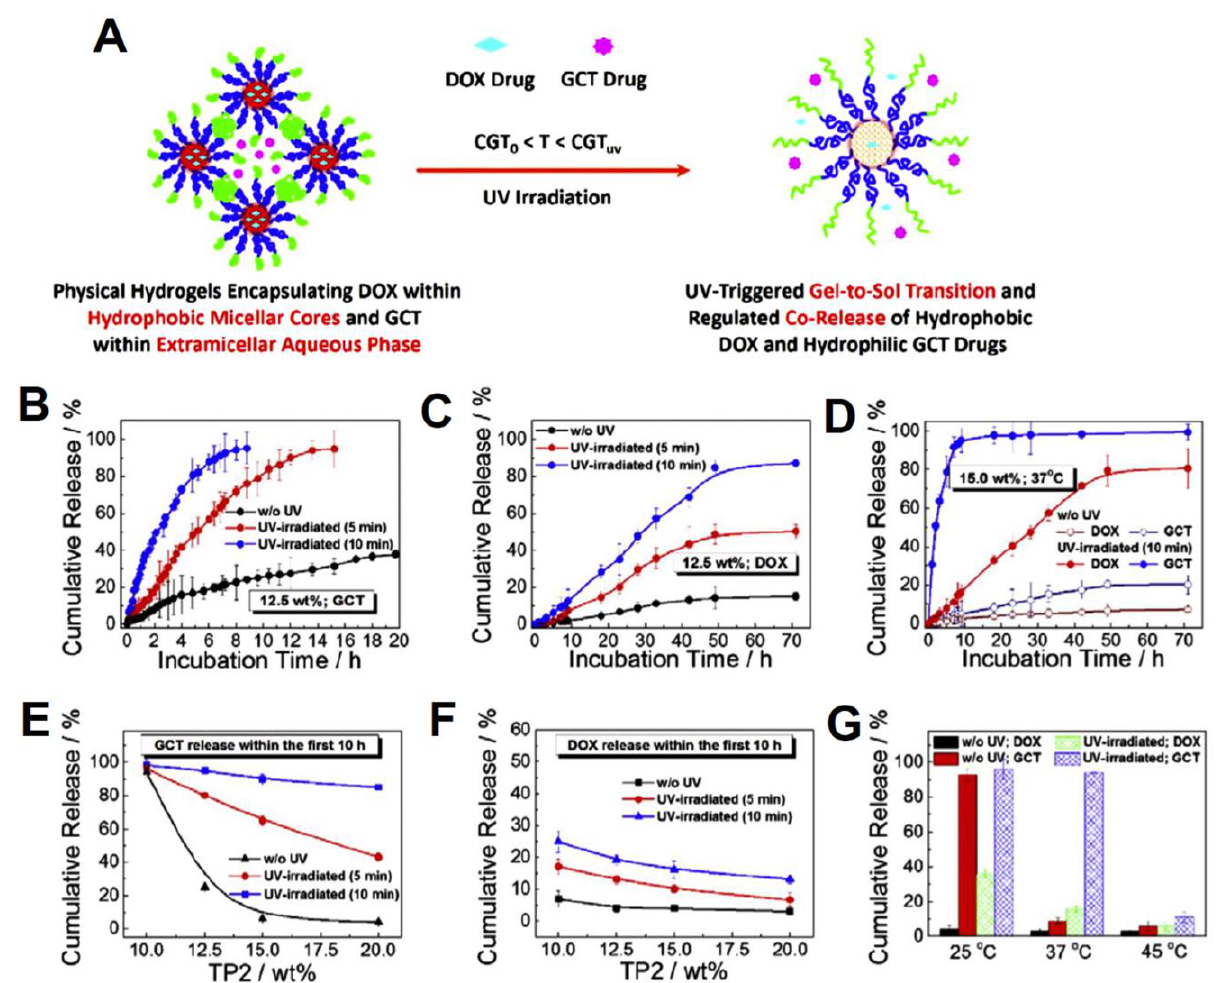
Figure 10. Temperature and UV irradiation affect the drug release profiles of DOX and GCT. ( A ) A schematic illustrating the UV-induced gel-to-sol transition and thermal drug release from TP2 hydro- gels containing DOX encapsulated in hydrophobic micellar centers and GCT in the extra micellar aqueous media. ( B ) GCT release profile with and without UV irradiation. ( C ) DOX release profile with and without UV irradiation. ( D ) A comparison of DOX and GCT release profiles after 10 min of UV irradiation to DOX/GCT co-loaded TP2 hydrogels (15.0 wt. %) at 37 ◦ C. ( E ) GCT cumulative release from TP2 hydrogels with and without UV irradiation in the first 10 h. ( F ) DOX cumulative release from TP2 hydrogels with and without UV irradiation in the first 10 h. ( G ) Comparison of DOX and GCT cumulative release from with and without UV irradiation (10 min) from TP2 hydro- gels (15.0 wt. %; pH 7.4 buffer) throughout the first 10 h with temperature as the main alternative. Reproduced from Wang et al. [180], with permission from Elsevier.